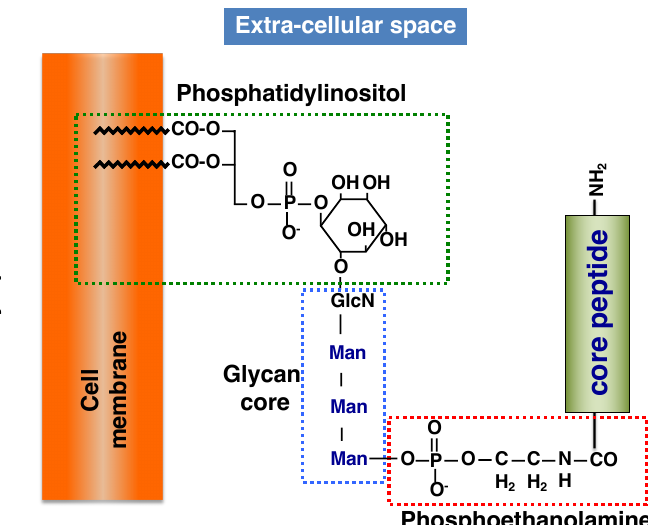
Figure 1. Schema of glycosylphosphatidylinositol-anchored protein (GPI-AP) structure . The C-terminus of core peptide binds to phosphoethanolamine followed by three mannose (Man) residues and glucosamine (GlcN). The glycan core further links to